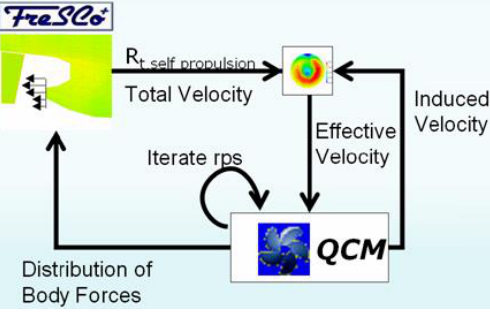
Figure 9. Numerical self-propulsion test scheme.